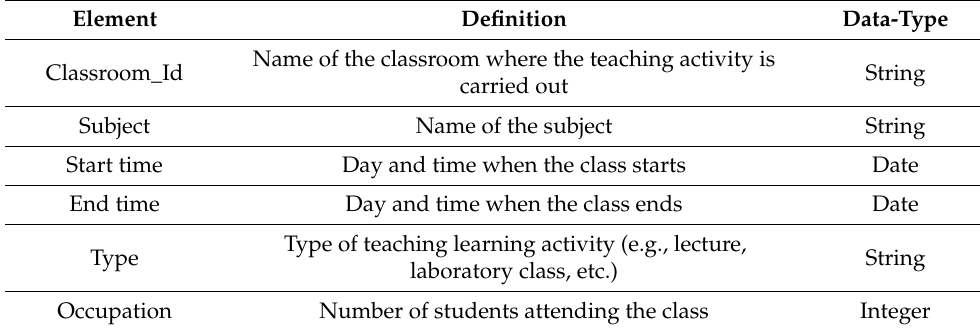
Table 3. Characteristics of teaching activities.